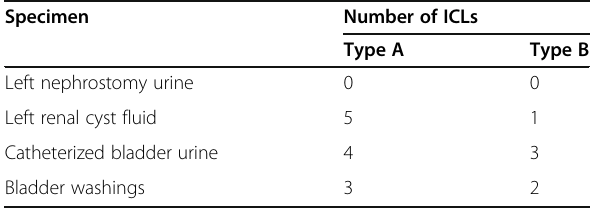
Table 1 Intracytoplasmic lumina in cytology